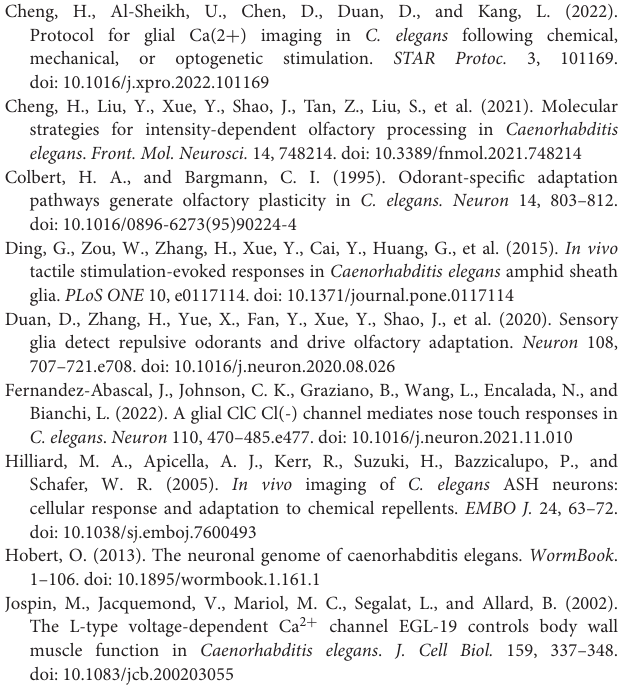
Figure 3 . (A,B) Morphologies of ASH neurons (A) and AMsh glia (B) in mock and AMsh glia-specific egl-19 RNAi worms at D1 stage, respectively. Scale bar, 20 µ m. (C,E) The lengths of the anterior processes (C) and soma (E) of ASH neuron in mock and AMsh glia-specific egl-19 RNAi worms at D1 stage, respectively. Mock (ST2996), n = 17; AMsh glia-specific egl-19 RNAi (ST2995), n = 16; unpaired t -test. (D,F) The ratio of the anterior processes (D) and soma (F) of ASH neurons to the lengths of the second pharynx in mock and AMsh glia-specific egl-19 RNAi worms at D1 stage, respectively. The lengths of the second pharynx is calculated as the distance from nose tip to the middle of the second pharynx. Mock (ST2996), n = 17; AMsh glia-specific egl-19 RNAi (ST2995), n = 16; unpaired t -test. (G,I) The lengths of anterior processes (G) and soma (I) of AMsh glia in mock and AMsh glia-specific egl-19 RNAi worms at D1 stage, respectively. Mock (ST2674), n = 16; AMsh glia-specific egl-19 RNAi (ST2729), n = 27; unpaired t -test. (H,J) The ratio of the anterior processes (H) and soma (J) of AMsh glia to the lengths of the second pharynx in mock and AMsh glia-specific egl-19 RNAi worms at D1 stage, respectively. The lengths of the second pharynx is calculated as the distance from nose tip to the middle of the second pharynx. Mock (ST2674), n = 16; AMsh glia-specific egl-19 RNAi (ST2729), n = 27; unpaired t -test. Error bars represent SEM. ∗∗∗ p <